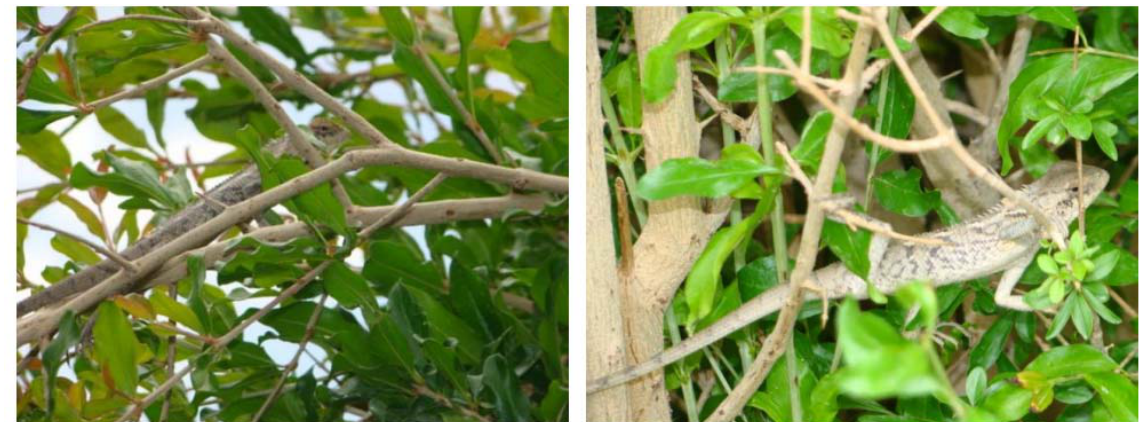
Baluchestan province, Iran.